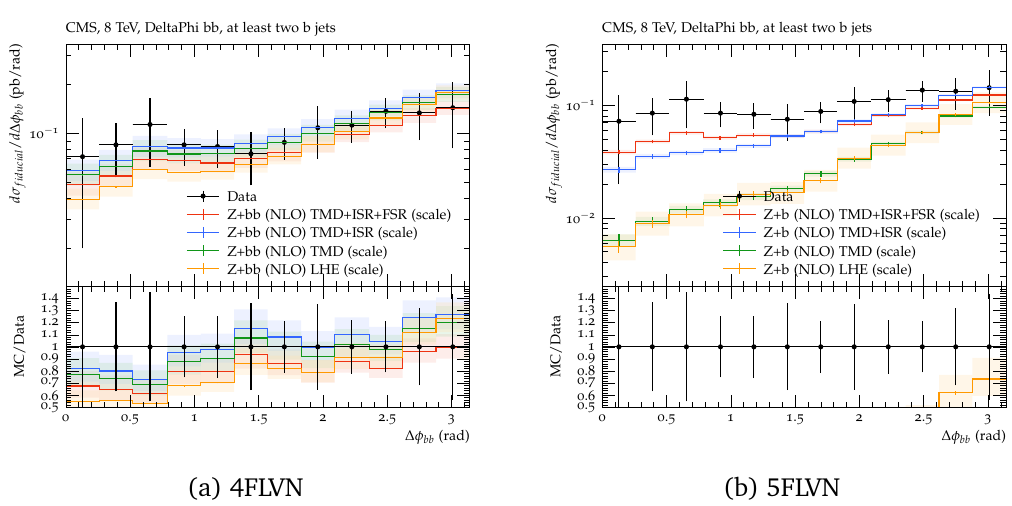
Figure 1: Differential cross section for Z + b¯b tagged jets as a function of azimuthal (cid:112) s = 8 TeV. The 4FLVN-prediction angular separation as measured by CMS [ 10 ] at is shown in (a), the 5FLVN-prediction in (b). The LHE files (parton level), after inclusion of PB-TMDs, initial state parton shower and final state parton shower are illustrated separately.